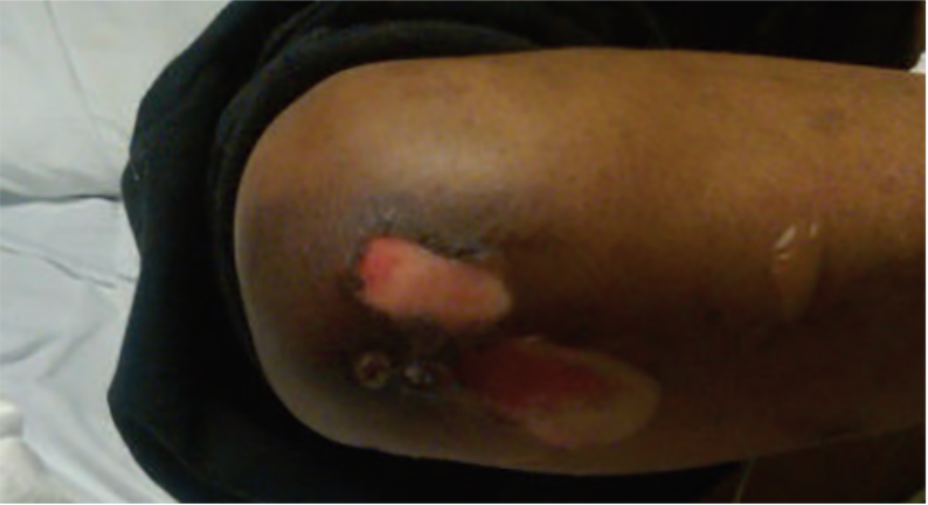
Figure 5. Image used in the prototype to show the patient’s past ailment. Note. Image adapted from Bullosis diabeticorum: Rare presentation in a common disease, by Gupta V, Gulati N, Bahl J, Bajwa J, and Dhawan N, 2014, Case Reports in Endocrinology, p.